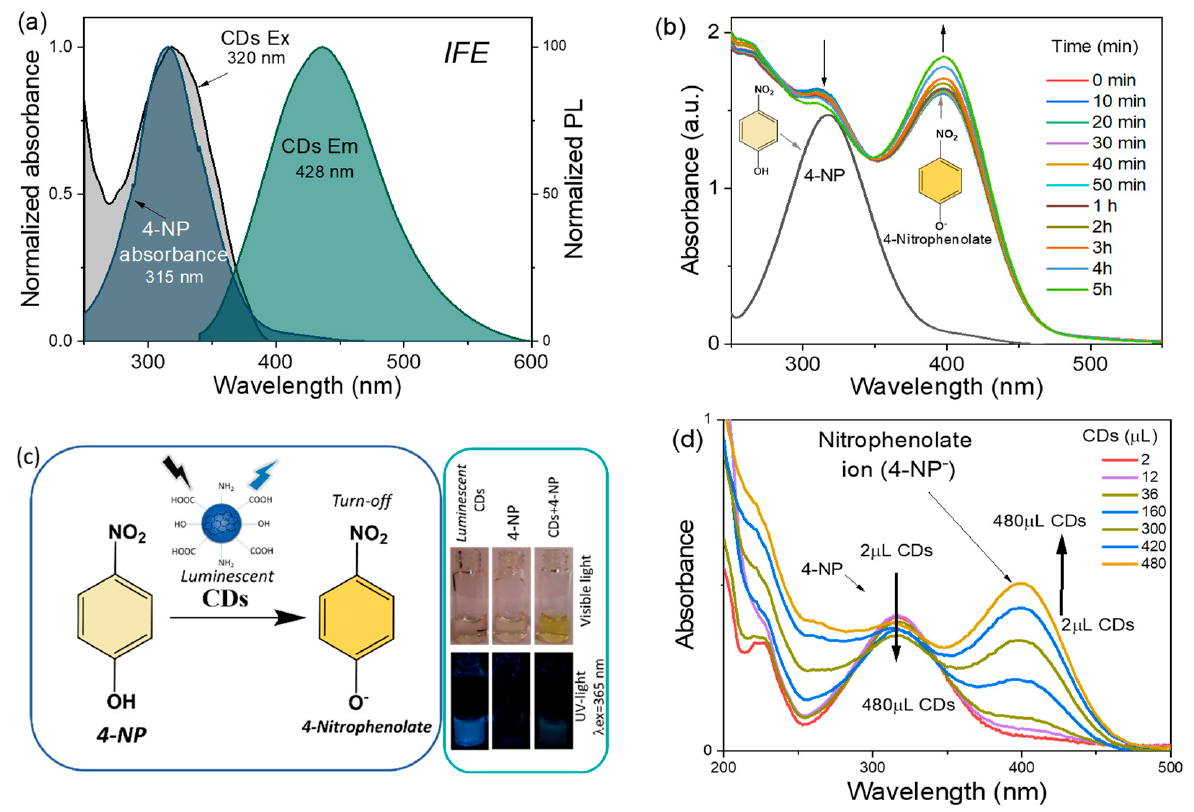
Figure 5. ( a ) Inner filter effect projected as a possible mechanism of 4-NP sensing/deprotonation, ( b ) changes in 4-NP + CDs absorbance at different times, ( c ) schematic representation of possible mechanism of PL quenching and images showing the change of color in visible light and under UV light, and ( d ) evolution of 4-nitrophenolate ion peak at different concentrations of CDs at initial time. Moreover, a redshift in the PL signal (when either the 4-NP or Cr(VI) concentration is increased) was observed. According to Zhang et al., the emission peak shift in PL bands